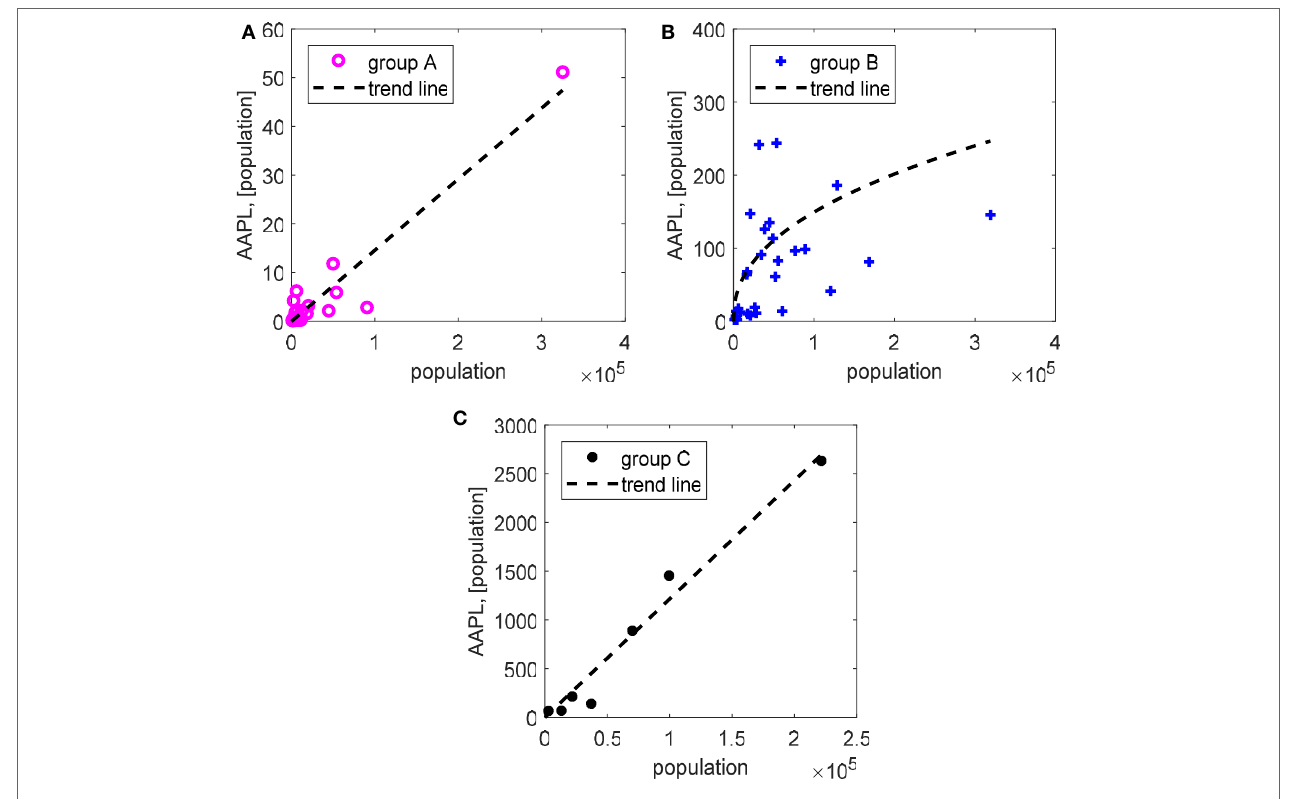
FigUre 5 | The trend between the AAPL and population (a) Group A, (B) Group B, (c) Group